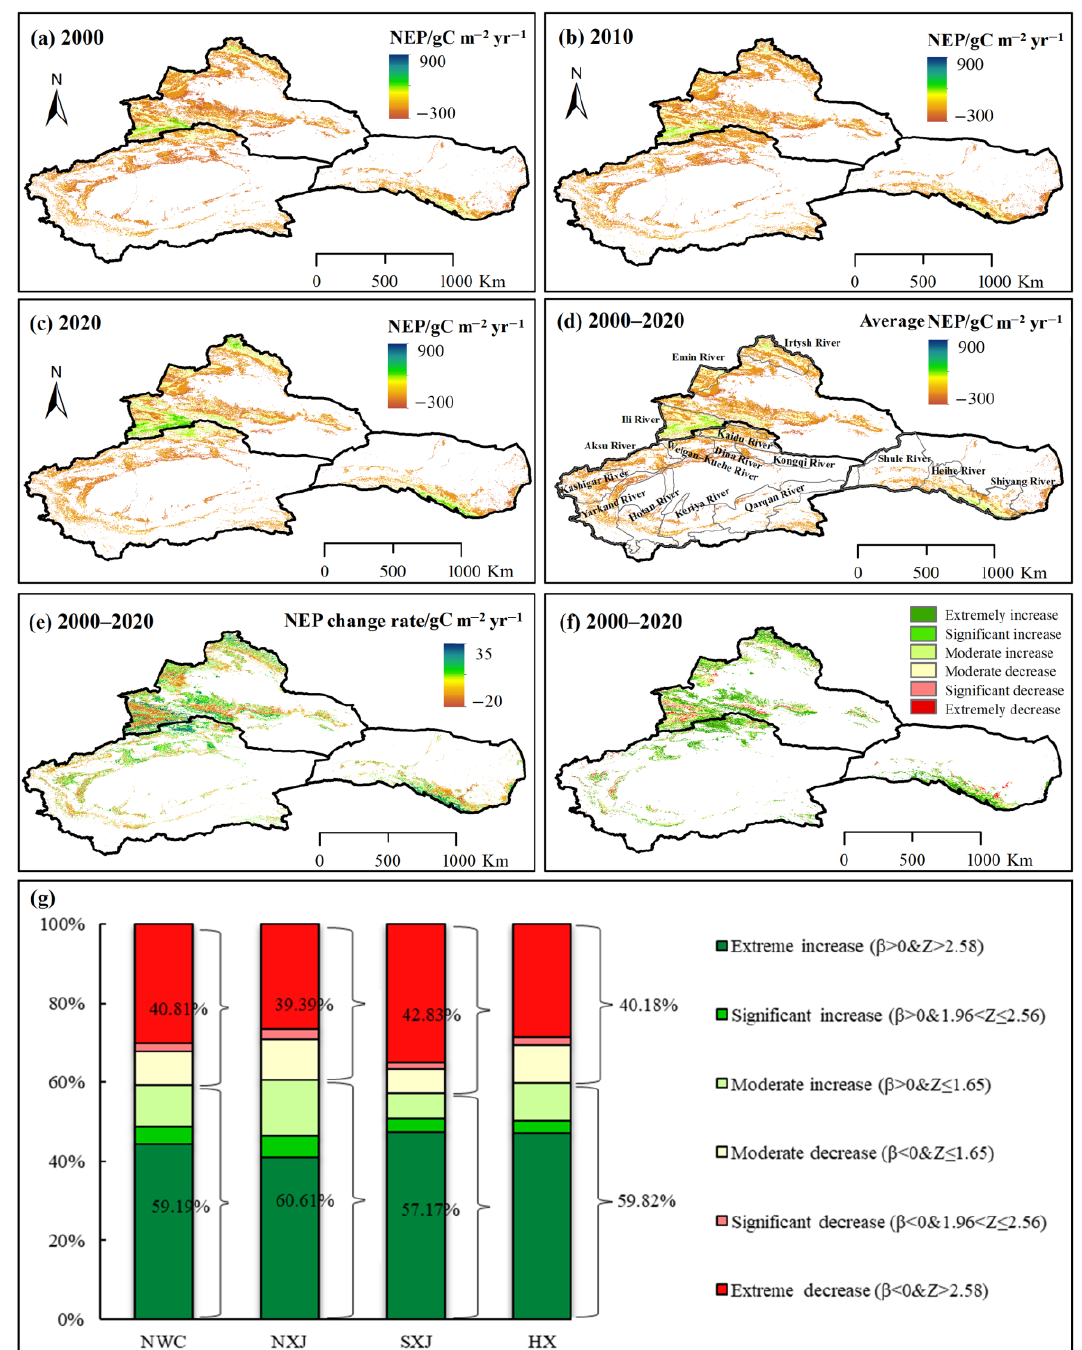
Figure 2. Spatial distribution and variations of NEP in NXJ, SXJ and HX in northwest China. Spatial distribution of NEP during ( a ) 2000, ( b ) 2010, and ( c ) 2020; ( d ) spatial distribution of average NEP during 2000 – 2020; ( e , f ) spatial variations of NEP during 2000 – 2020; ( g ) Proportion variations of NEP during 2000 – 2020 . (Note: mountain ≥ 1500 m; plain < 1500 m).